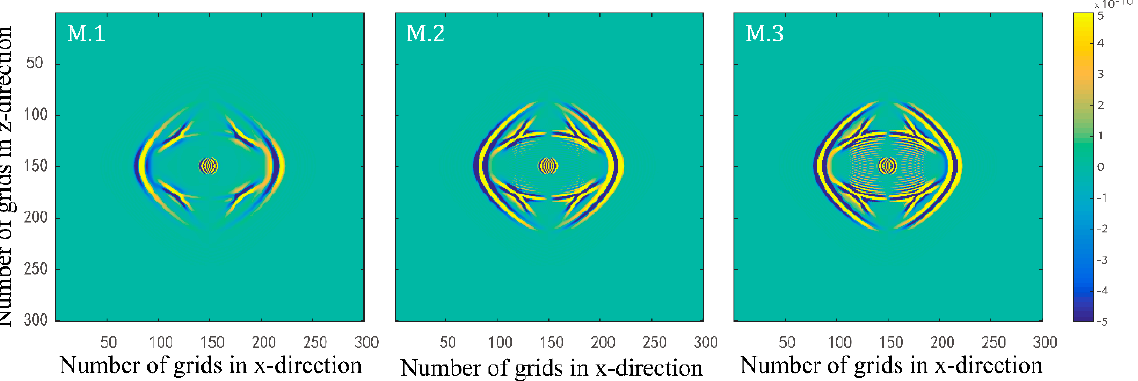
Figure 6. Snapshots of liquid phase x–direction velocity components with three different quality factor groups at t = 0.15 s.